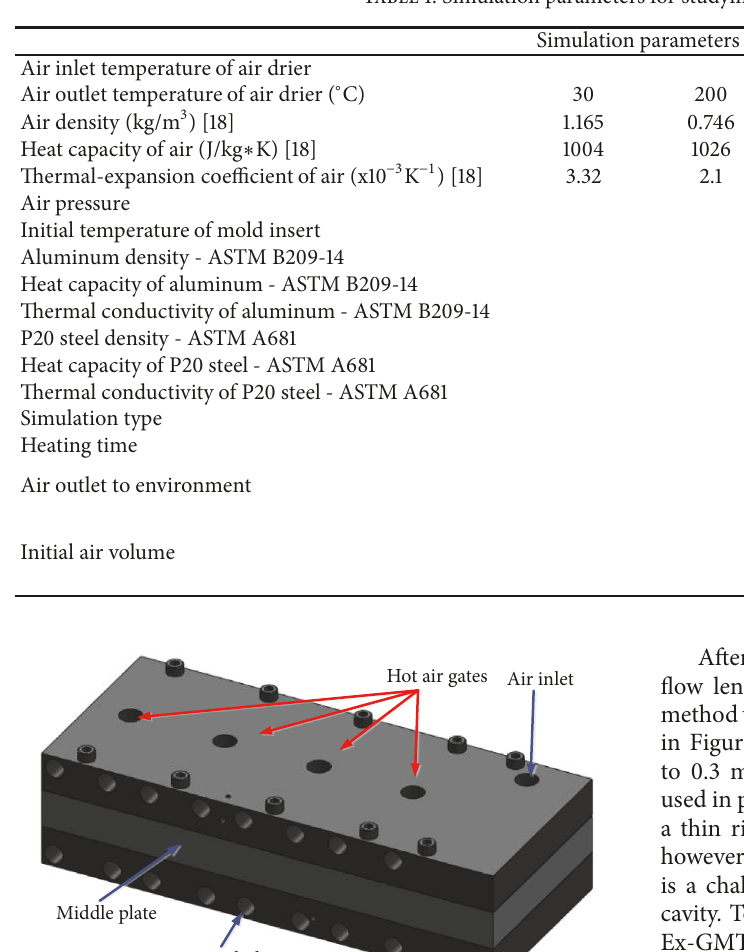
Table 1: Simulation parameters for studying melt flow length.